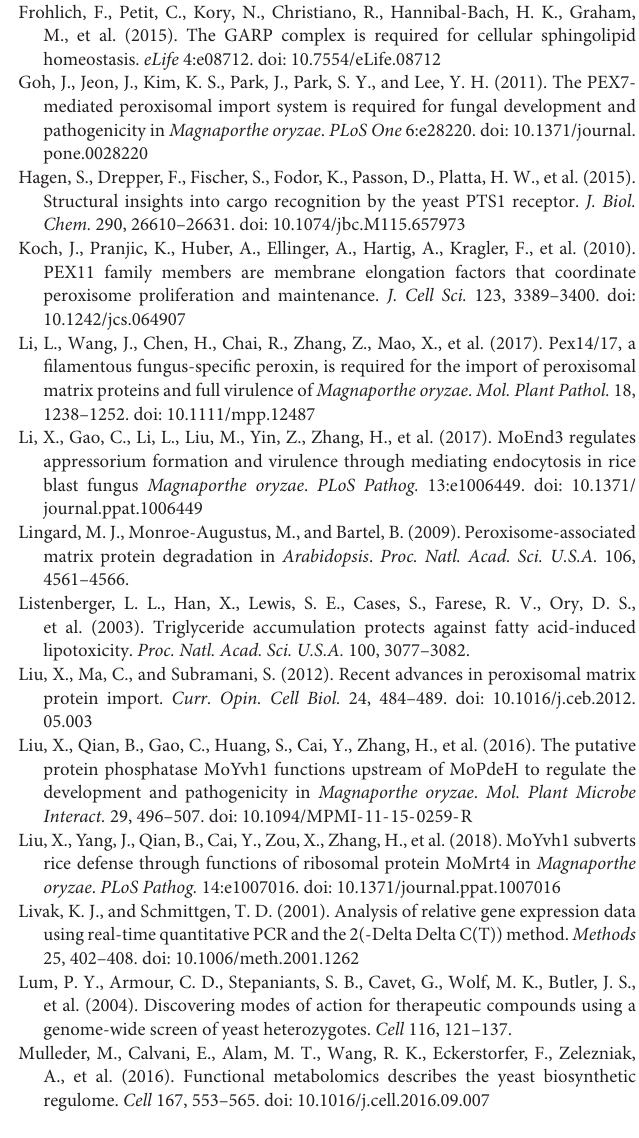
Supplementary Figure 1 | Targeted deletion of MoPCS60 in M. oryzae . (A) MoPCS60 gene replacement strategy in M. oryzae genome. (B) MoPCS60